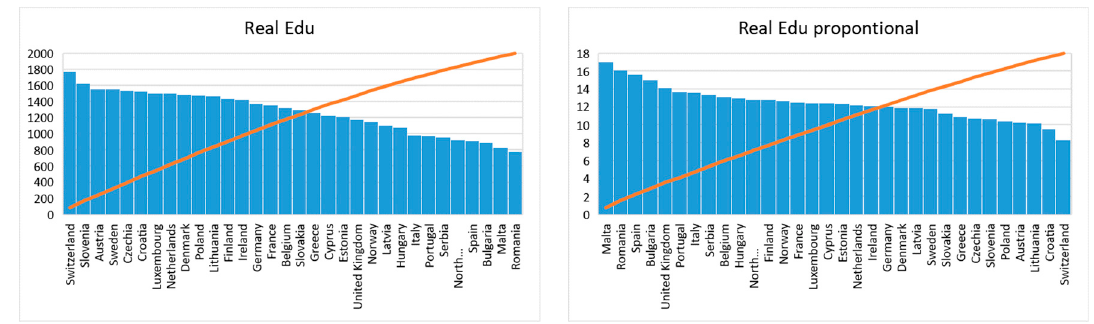
Figure 27. Compared real values, Edu factors.